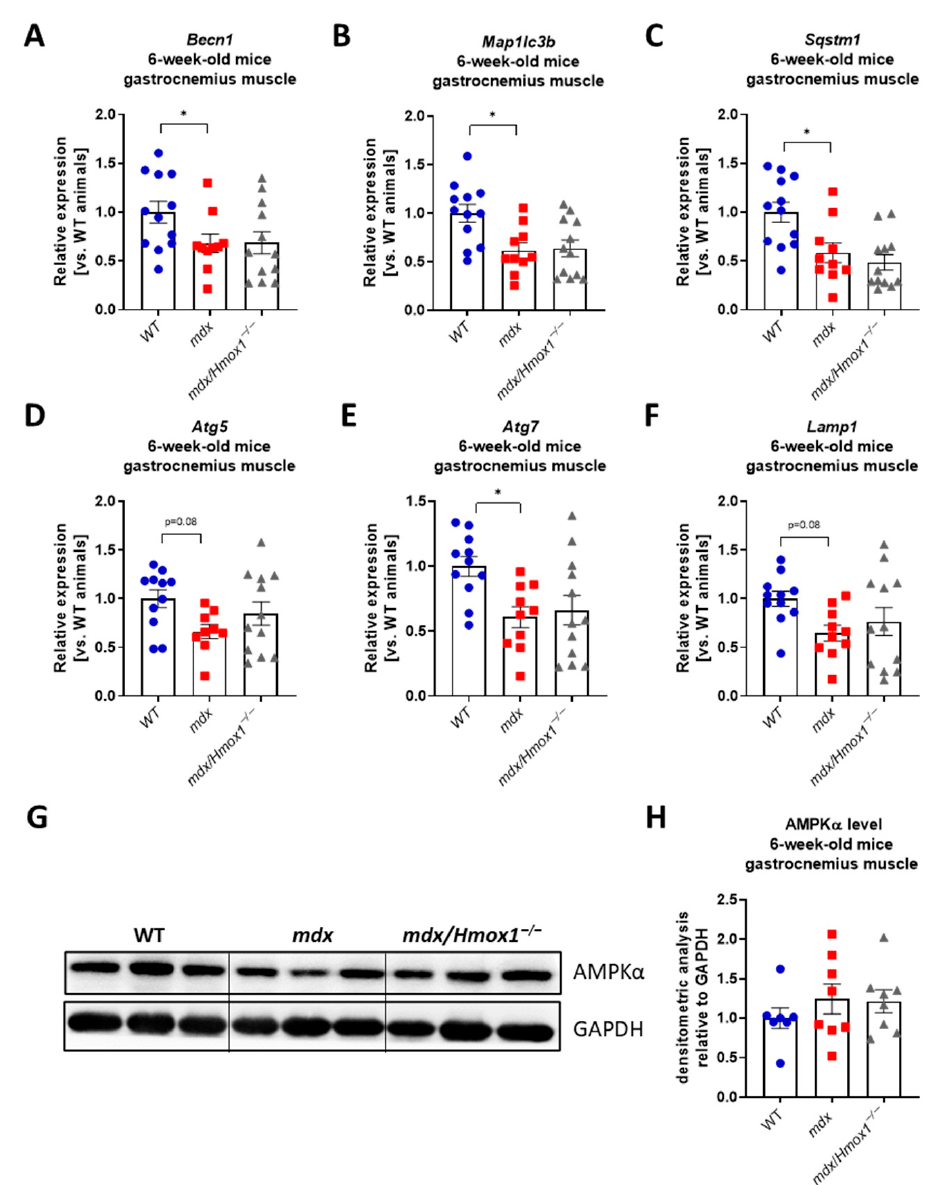
Figure 2. The expression of several genes regulating autophagy is decreased in gastrocnemius of 6-week-old mdx mice without the further influence of Hmox1 deficiency. Analysis of mRNA levels of factors regulating autophagy in gastrocnemius muscle of WT, mdx , and mdx / Hmox1 − / − mice. The expression of Becn1 ( A ), Map1lc3b ( B ), Sqstm1 ( C ), Atg5 ( D ), Atg7 ( E ), and Lamp1 ( F ) was analyzed by qRT-PCR; n = 9–12/group; Results presented as mean ± SEM. The protein level of AMPK α presented by Western blot ( G ) and its densitometric analysis ( H ), n = 7–8/group. GAPDH was used as a loading control. Results presented as mean ± SEM. * p < 0.05 by one-way ANOVA with Tukey’s post hoc test.